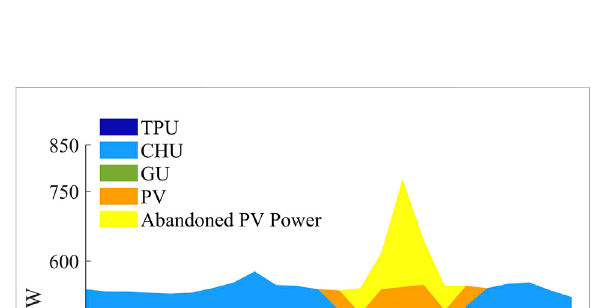
FIGURE 4 HTSGS scheduling results in Scenario 1.